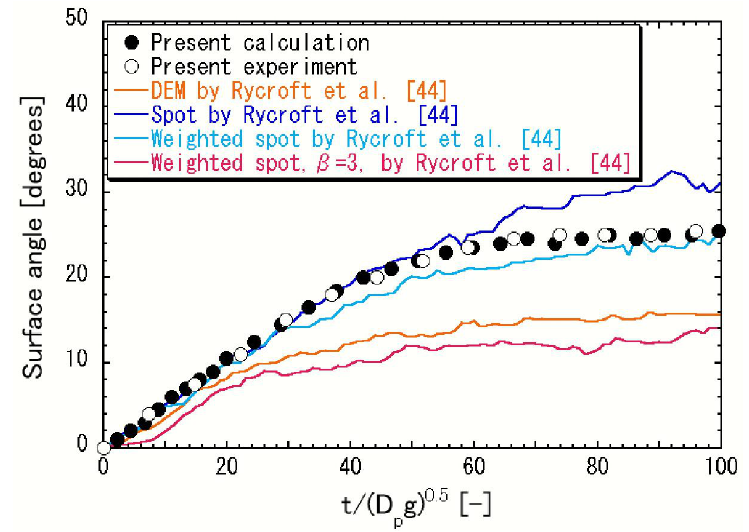
Figure 5. Time evolution of the free surface